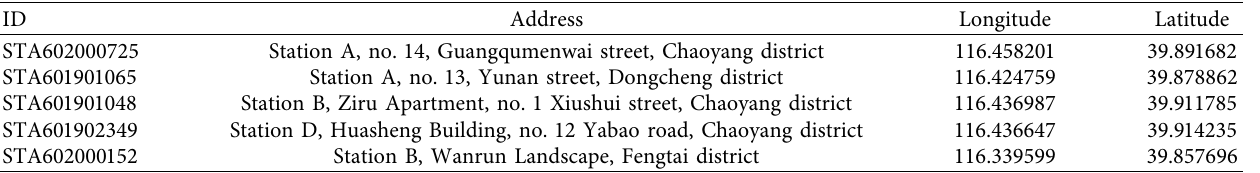
Table 1: An example of the BSS information.